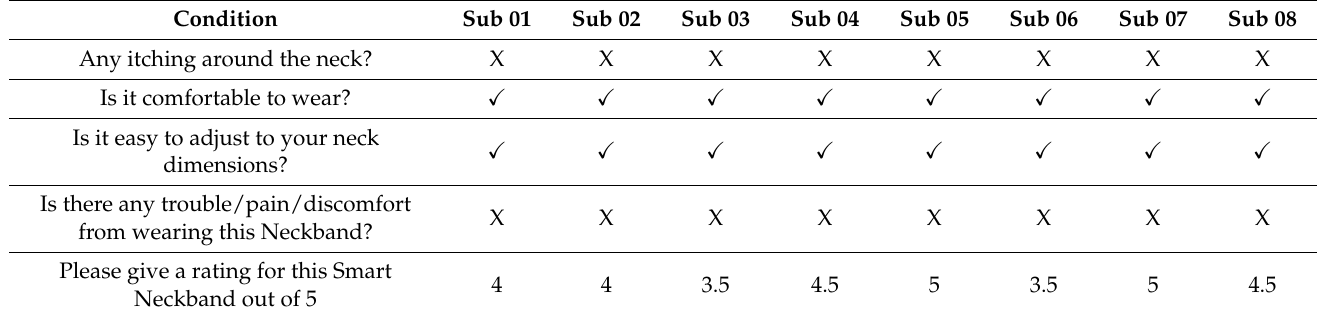
Table 3. Participants’ feedback on wearing Smart